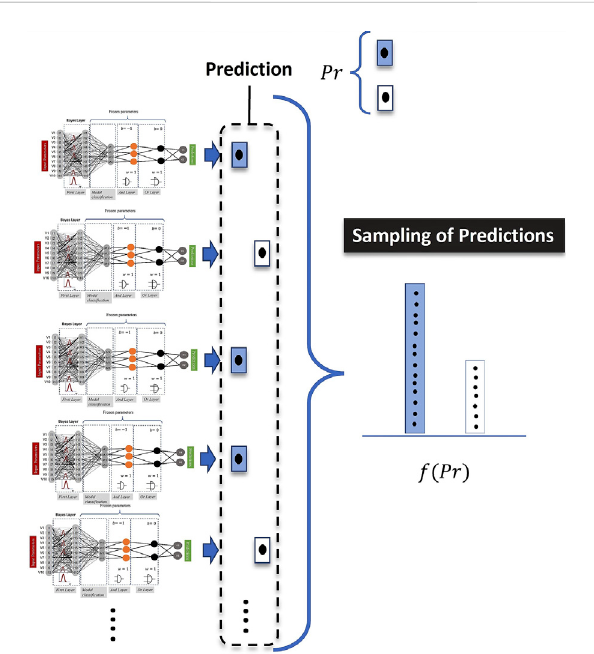
FIGURE 4 Intuitive meaning of the application of Bayes in the model de fi nition. For the computation of a single prediction, the computed results are sampled.